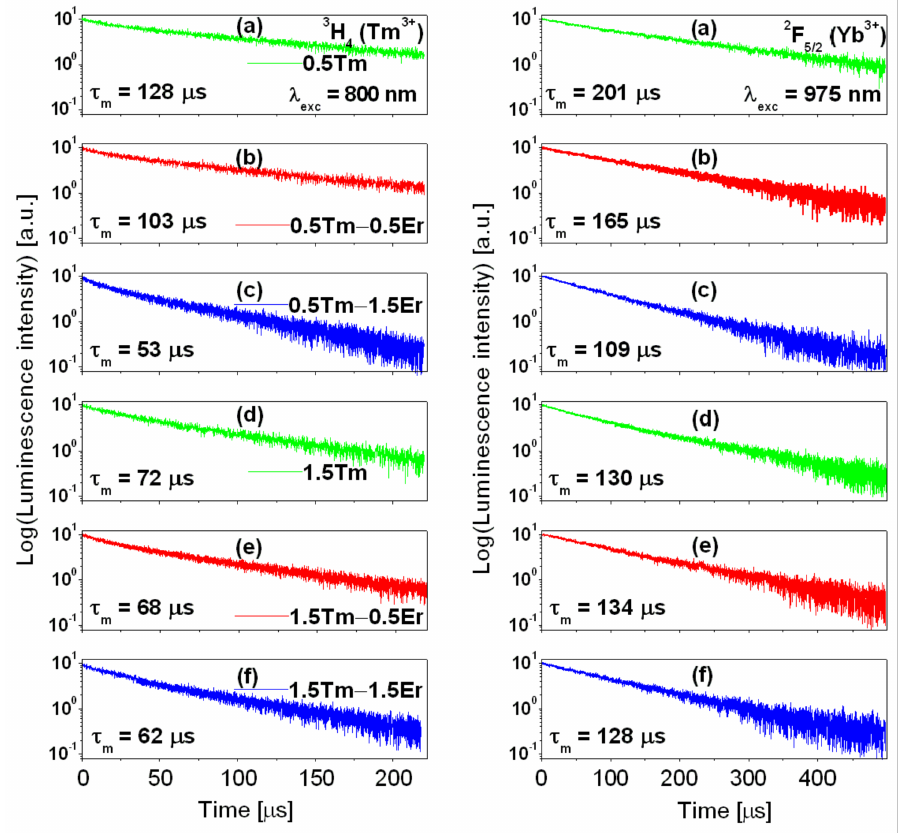
Figure 3. Luminescence decays from the 3 H 4 (Tm 3+ ) and 2 F 5/2 (Yb 3+ ) excited states. For luminescence decays measured under 800 nm excitation, the curves for both simul- taneously and resonantly excited states 3 H 4 (Tm 3+ ) and 4 I 9/2 (Er 3+ ) should be observed, because the positions of these states on the energy level diagram are nearly the